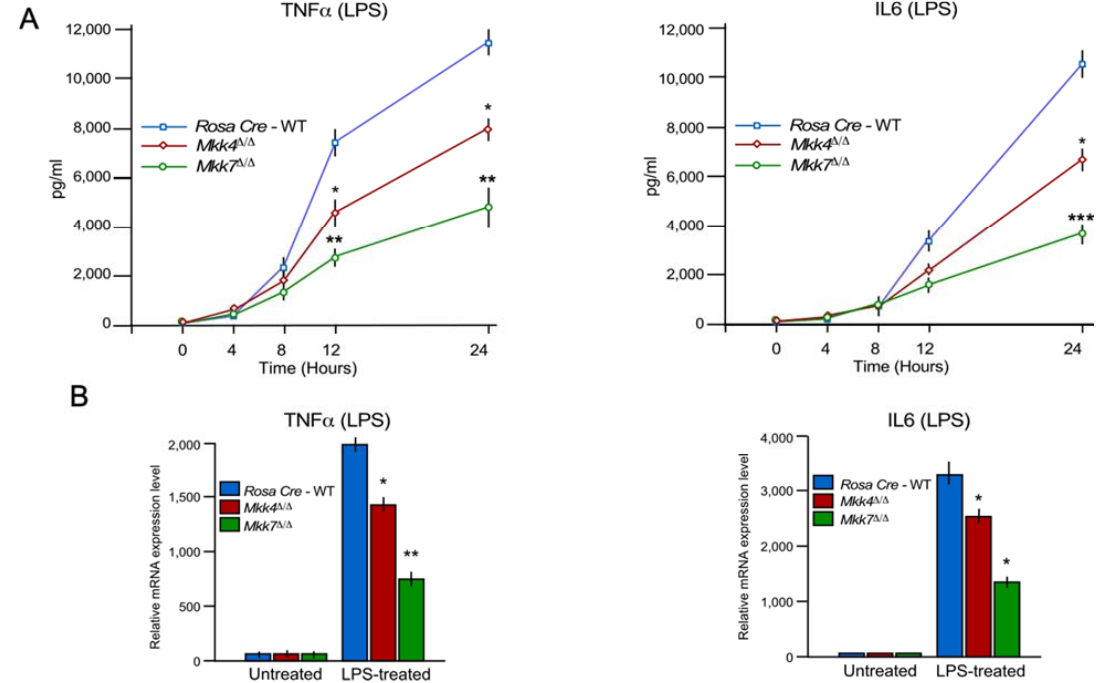
Figure 3. The MKK4 and MKK7 pathway contribute to LPS-stimulated and cytokine production in macrophages. ( A , B ) Rosa26-Cre ERT , Mkk4 ∆ / ∆ and Mkk7 ∆ / ∆ BMDMs were treated with 100 ng/mL LPS. The amount of TNF α and IL6 in the culture medium was measured by ELISA ( A ), and RT-qPCR was performed to measure mRNA production of TNF α and IL6 ( B ) (mean ± S.E.M.; n = 6–8). Statistically significant differences between groups are indicated. (*) p < 0.05; (**) p < 0.01; (***) p < 0.001 vs. WT. All the experiments were repeated 3–4 times.